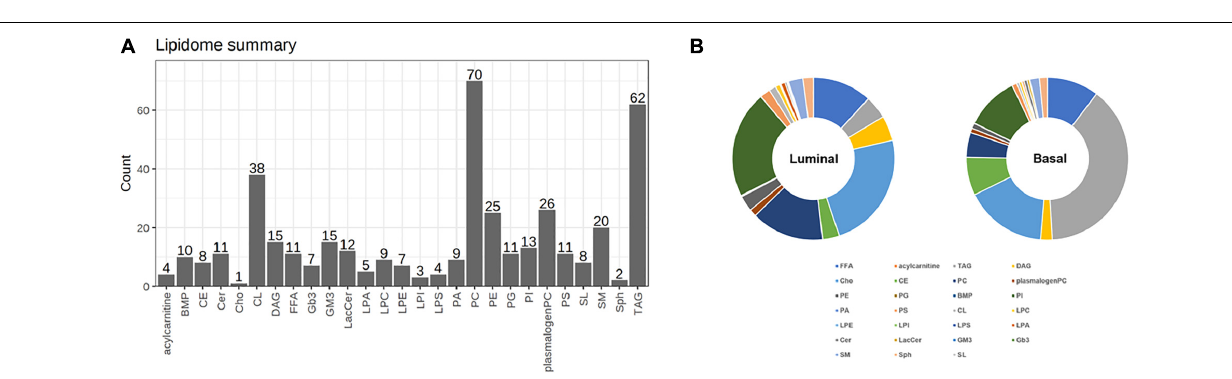
FIGURE 2 | Distinct lipid profiles in basal and luminal MIBC subtypes. (A) The lipid types and amounts tested. (B) The relative frequencies of lipids in basal and luminal MIBC subtypes. BMP, bis (monoglycerol) phosphate ester; CE, cholesteryl esters; Cer, ceramides; Cho, free cholesterols; CL, cardiolipins; DAG, diacylglycerols; FFA, free fatty acids; Gb3, Ceramide trihexoside; GM3, monosialogangliosides; LacCer, lactosylceramides; LPA, lyso-PA; LPC, lyso-PC; LPE, lyso-PE; LPI, lyso-PI; LPS, lyso-PS; PA, phosphatidic acids; PC, phosphatidylcholines; PE, phosphatidylethanolamines; PG, phosphatidylglycerols; PI, phosphatidylinositols; PS, phosphatidylserines; SL, sulfatides; SM, sphingomyelins; Sph, sphingosine; TAG,